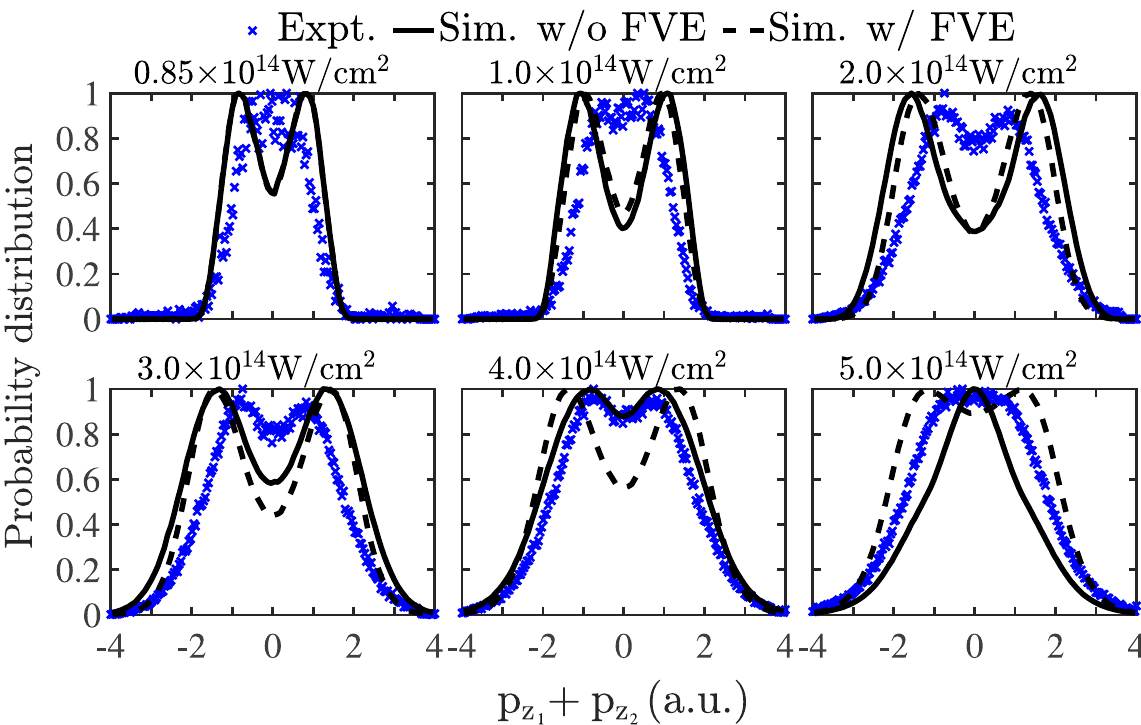
Figure 4. Probability distribution of the sum of the two electron momentum components parallel to the polarization of the laser field for laser field intensities from 0.85 × 10 14 W/cm 2 to 5 × 10 14 W/cm 2 . The computed results with the focal volume effect not accounted for are denoted by black solid lines and when it is accounted for by black dashed lines; the blue crosses denote the experimental results 8 . Each probability distribution is divided by its maximum